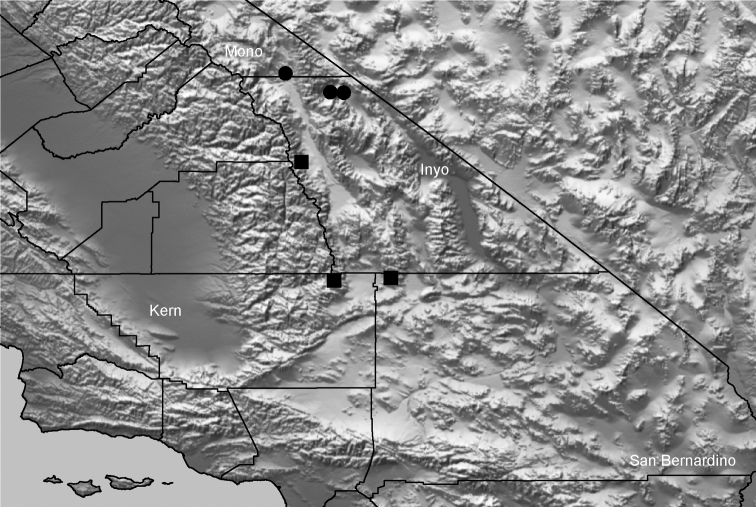
Distribution of Aptostichus sarlacc sp. n. (filled squares) and Aptostichus derhamgiulianii sp. n. (filled circles).